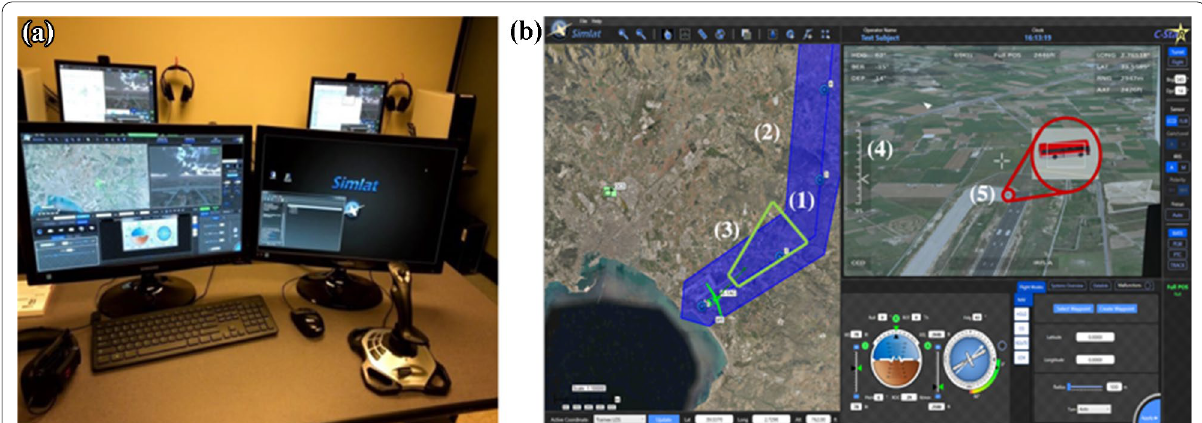
Fig. 1 Unmanned aerial system training simulator. A The simulator allows for two trainees and one instructor. B The trainee screen is divided into map screen on the left and payload or sensor screen on the right. The map screen displays the route that the aircraft will fly along (1), the area where the scan and target find task are assigned (2), and what region the sensor screen is capturing (3). The payload screen displays real-time visual of the landscape being looked at with feedback regarding the zoom level (4). This screenshot also shows how the target (5), a red civilian bus, looks like from a distance and when it is being tracked at a zoom angle of 3°